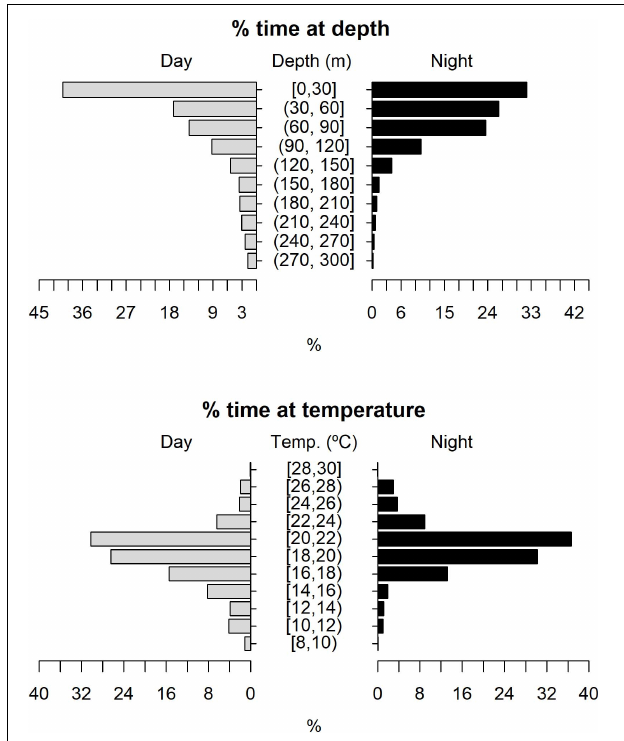
FIGURE 6 | Vertical habitat use of shortfin makos for daytime and night-time in terms of depth and temperature. Depth classes are categorized in 30 m intervals and temperature classes in 2 ◦ C